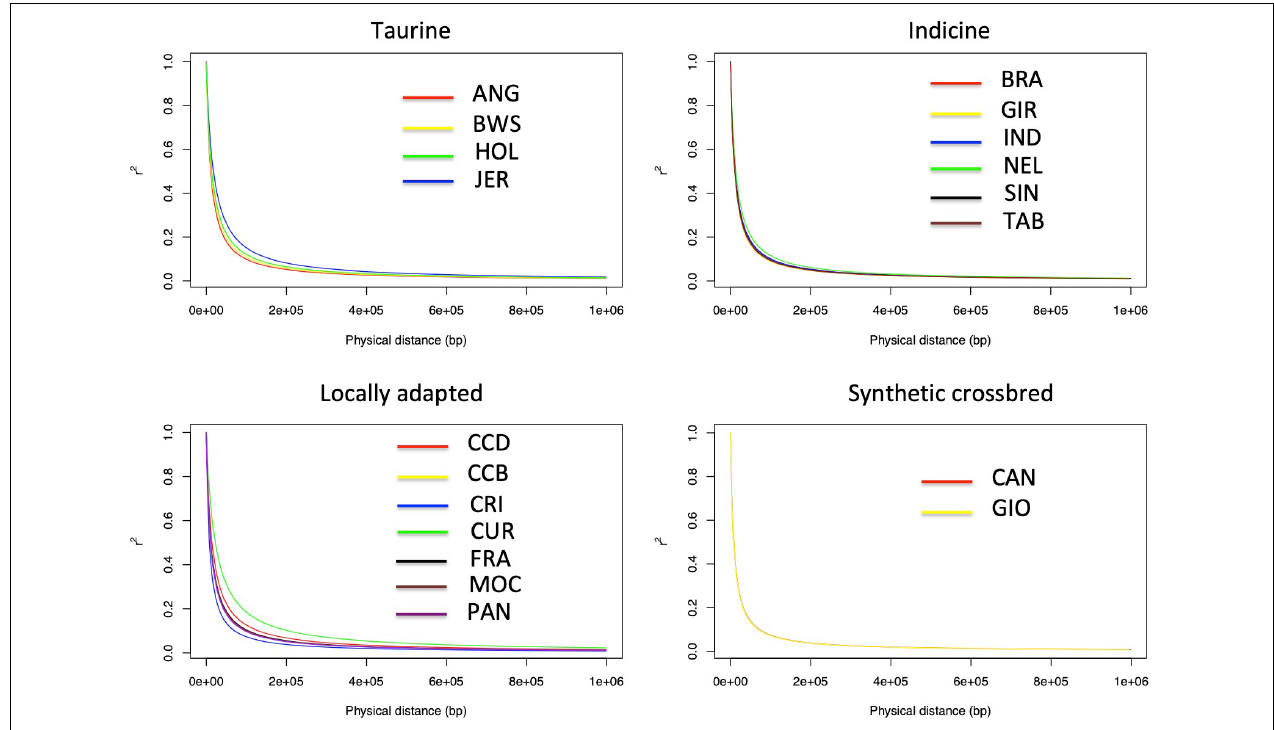
FIGURE 1 | Linkage disequilibrium decay of 19 cattle breeds raised in Brazil. Linkage disequilibrium decay illustrating the r 2 values across physical distance in base pairs (bp) of the bovine genome in the synthetic, taurine, indicine, and locally adapted groups. ANG, Angus; BWS, Brown Swiss; JER, Jersey; HOL, Holstein; BRA, Brahman; GIR, Gir; IND, Indubrasil; NEL, Nelore; SIN, Sindhi; TAB, Tabapuã; CCD, Caracu Dairy; CCB, Caracu Beef; CRI, CriouloLageano; CUR, CurraleiroPé-Duro; FRA, CriouloLageano do RS; MOC, MochoNacional; PAN, Pantaneiro: CAN, Canchim; GIO, Girolando.